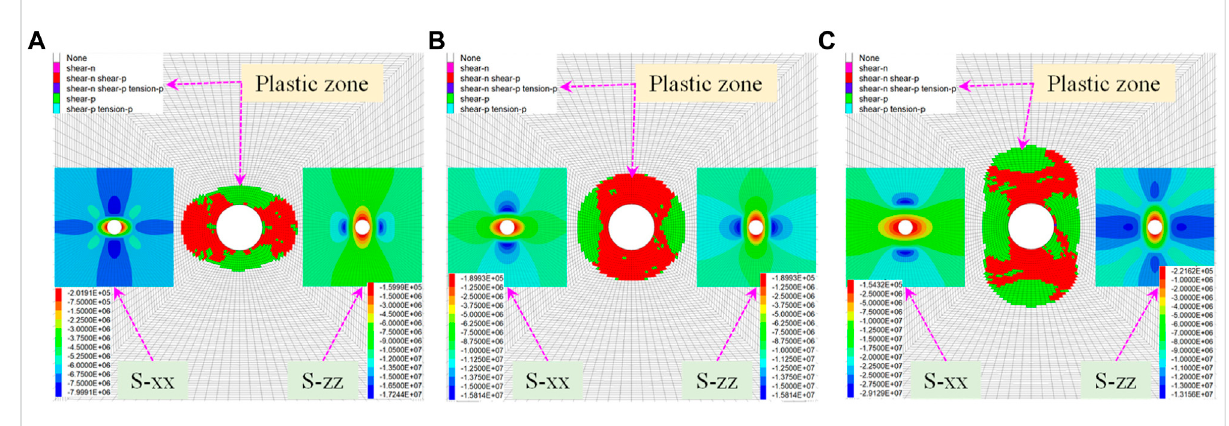
FIGURE 7 Steady-state evolution of the plastic zone in the nearby goaf road.